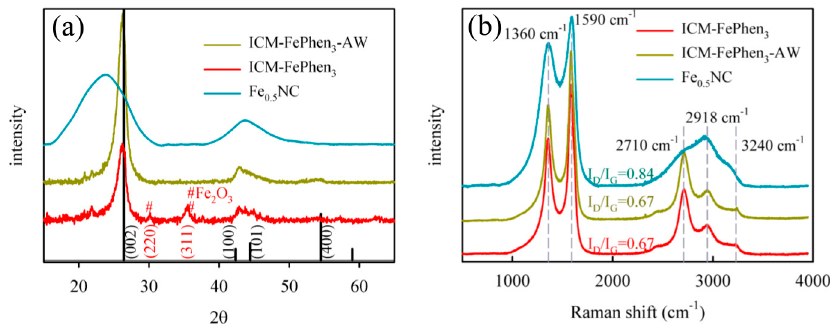
Figure 2. ( a ) X-ray diffraction (XRD) patterns, and ( b ) Raman spectra of ICM-derived